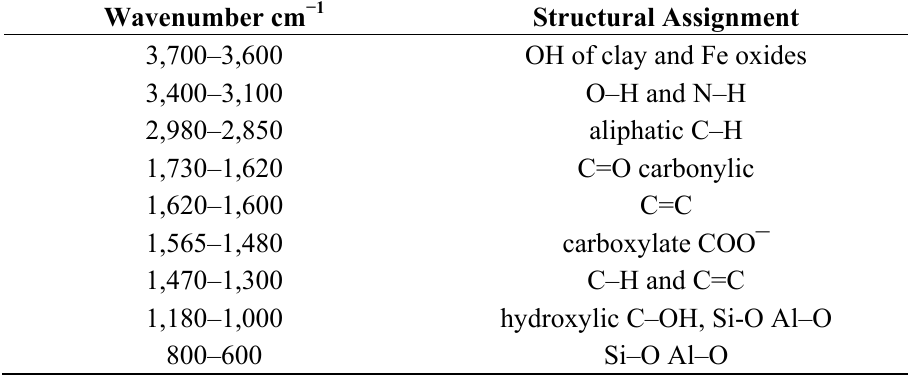
Table 2. Structural assignments of the main signals featured in a typical spectrum (Figure 2).